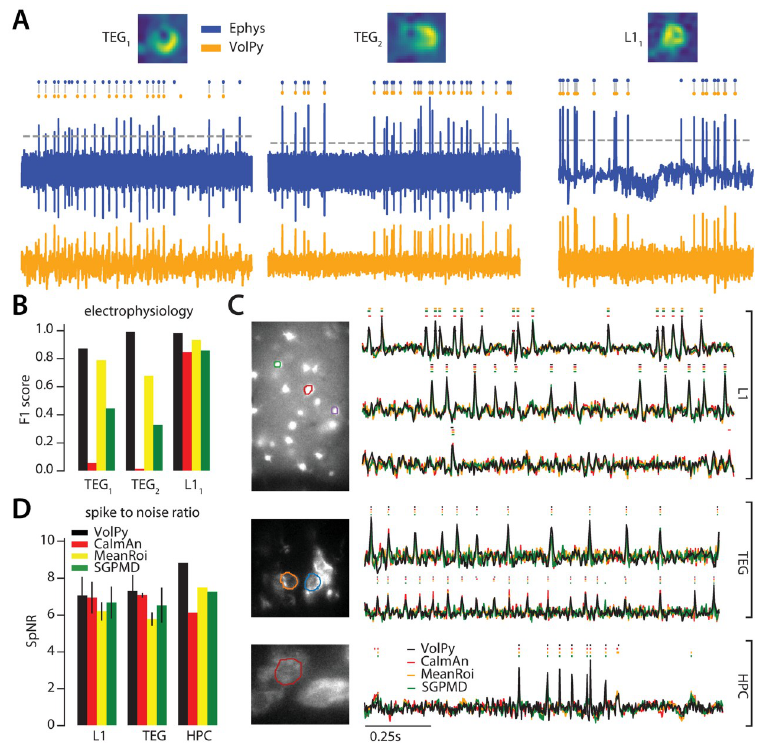
Fig 5. VolPy performance on real data. (A) Evaluation of VolPy spike extraction performance against simultaneous electrophysiology. Three neurons, two from larval zebrafish TEG area ( TEG 1 and TEG 2 ) and one from mouse L1 ( L 1 1 ), for which we had available both electrophysiology and imaging. Top. Spatial footprint extracted by VolPy . Middle. Ground truth spikes from electrophysiology (blue) and spikes extracted by VolPy (orange), gray vertical lines indicate matched spikes. Bottom. Electrophysiology (blue, top) and fluorescence signal denoised by VolPy (bottom, orange). (B) We compared the performance of VolPy , CaImAn , MeanROI, and SGPMD-NMF in retrieving spikes on the three neurons in (A). (C) Examples of trace extraction results for VolPy , CaImAn , MeanROI, and SGPMD-NMF. On the left mean image overlaid to example neurons (top L1, middle TEG, bottom HPC). On the right traces and inferred spikes for datasets L1 (top three traces), TEG (traces 4-5 from top) and HPC (bottom trace). (D) Spike to noise ratio (SpNR) for each considered algorithm and dataset